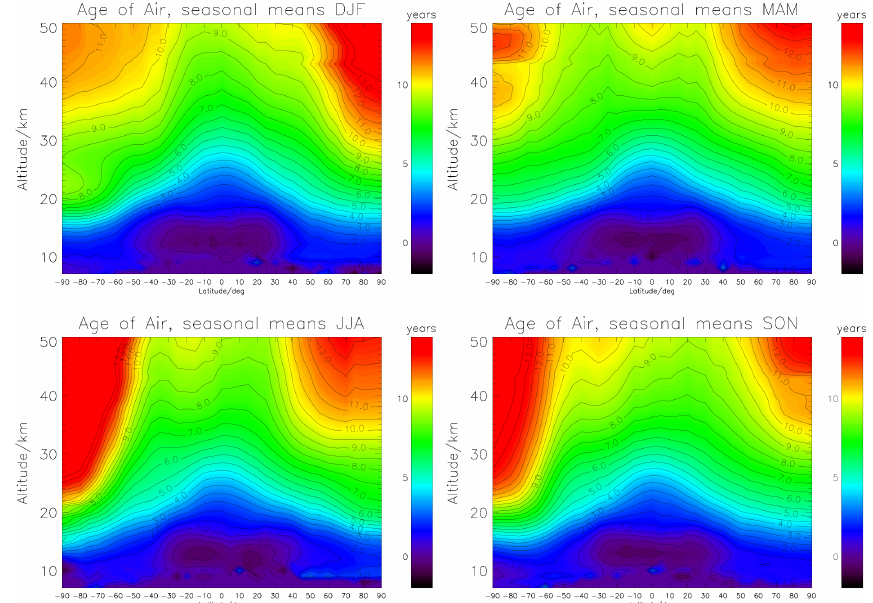
Figure 3. Zonal mean distribution of mean age of stratospheric air for the four seasons, derived by averaging MIPAS AoA data of all available years for the respective season.